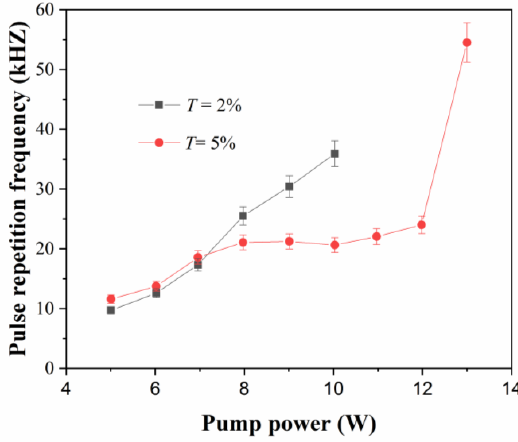
Figure 3. PRF of the PQS Tm,Ho:LuVO4 laser verse the pump power.